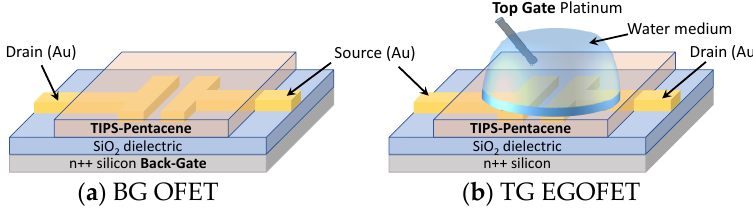
Figure 1. Graphical representation of the BG-OFETs ( a ) and TG-EGOFETs ( b ) architectures. As received, the substrates were cleaned in an ultrasonic bath with acetone to remove the protective layer of photoresist and other process residuals. A subsequent ultrasonic bath with isopropyl alcohol was done to remove any acetone residuals, promoting a less hydrophobic surface that allows for a better deposition of the semiconductor solution. After the cleaning procedure, half of the prepared substrates were treated with HMDS purchased from Sigma-Aldrich Chemical Co., St. Louis, MO, USA, whereas the other half were left untreated. The HMDS functionalization was performed by exposing the substrates for 2 h to HMDS vapor in a low vacuum